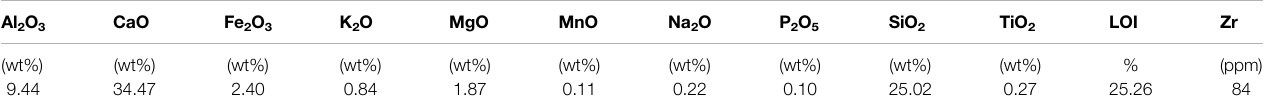
TABLE 1 | XRF results. Major elements are reported in weight percentage (%wt), Zr is reported in ppm. Other elements are considered irrelevant for this study, and thus omitted. LOI stands for loss of ignition. Al 2 O